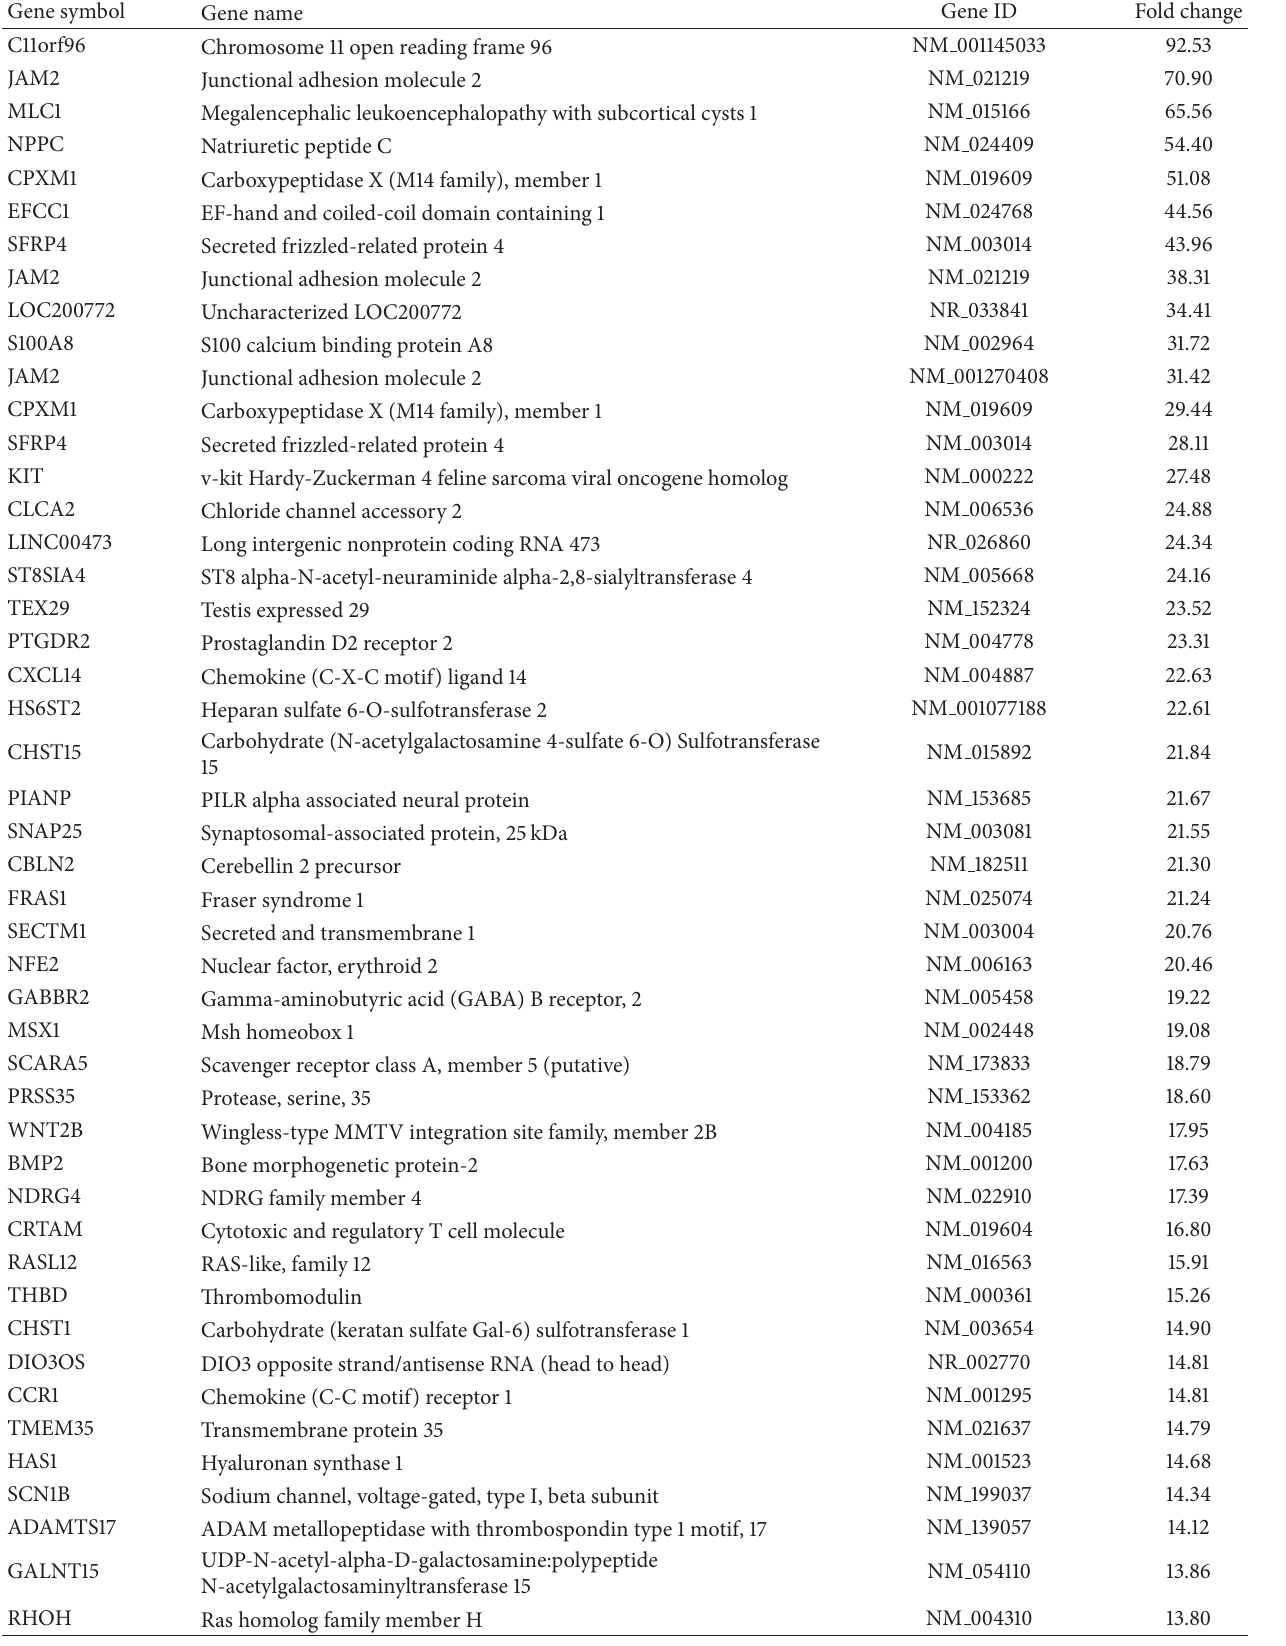
Table 2: The list of downregulated genes in MSX1-knockdown cells (top